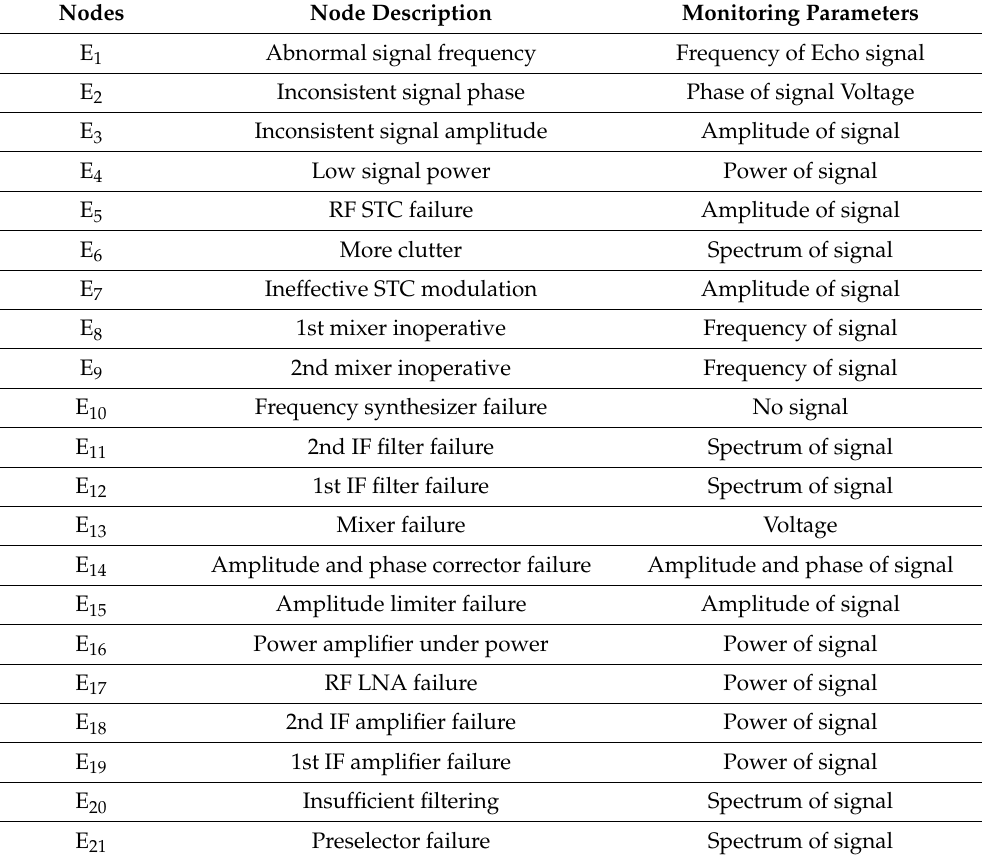
Table 2. Description of evidence nodes.